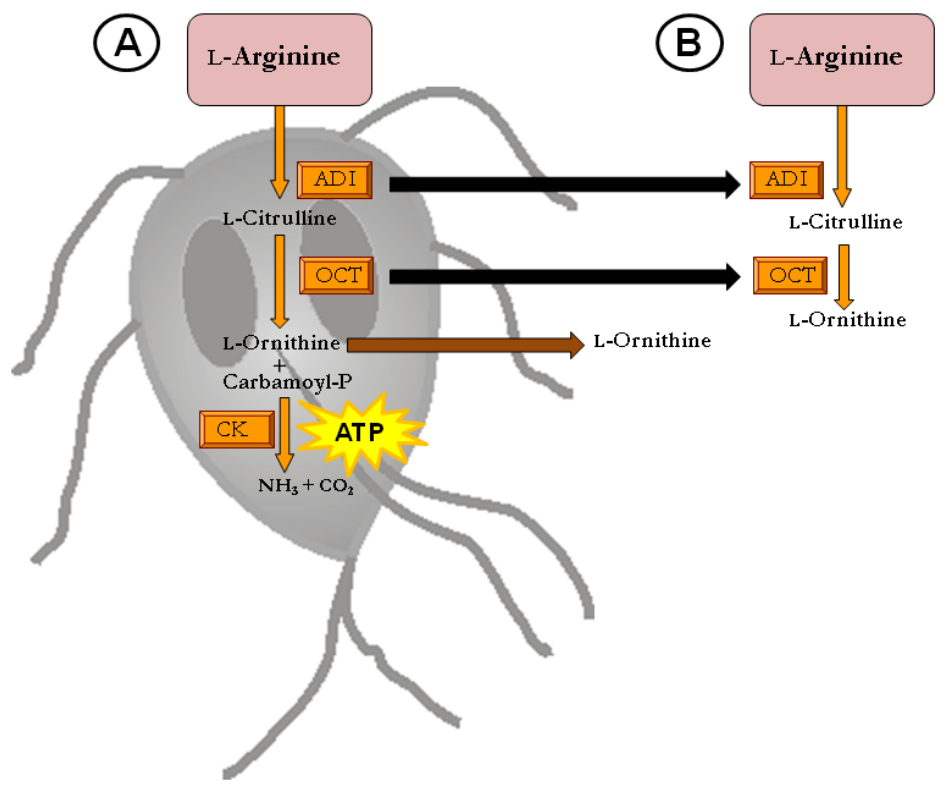
FIGURE 3. Role of ADI as a metabolic enzyme in Giardia. (A) L -Arg is taken up from the intestinal lumen to produce ATP via the ADH pathway, with L -ornithine being secreted. (B) Giardia ADI and OCT are released to